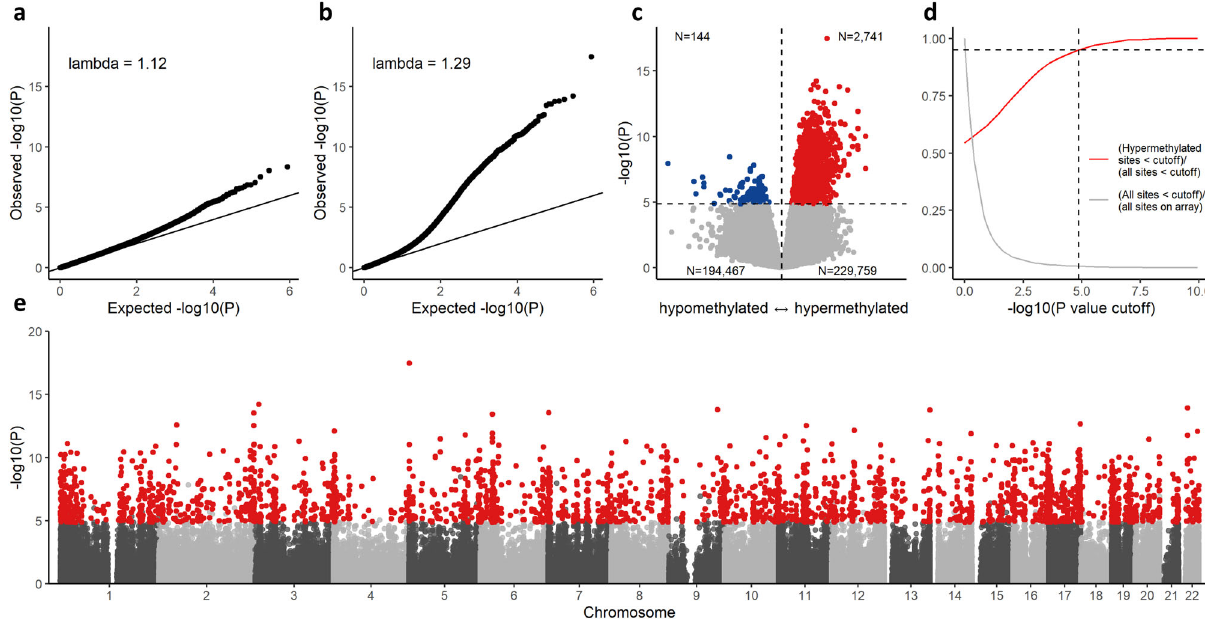
Fig. 1 Epigenome-wide association studies of DNMT3A and TET2 mutations. a QQ plot the P value distribution in differential methylation analyses by DNMT3A mutation status (55 DNMT3A -mutated inviduals compared to 189 individuals without CHIP). b Same as A, but comparing 44 TET2 -mutated individuals to 189 without CHIP. c Volcano plot of results from TET2 -speci fi c analyses. Horizontal dashed line indicates P = 1.4 × 10 − 5 . Numbers in corners indicate the number of CpG sites in each quadrant separated by dashed lines. Red and blue dots represent hyper- and hypomethylated CpG sites, respectively, below the signi fi cance threshold. d Selection of P value cutoff used in C. Red line displays the increasing proportion of hypermethylated sites with decreasing P value cutoff. Horizontal dashed line indicates 95% of sites are hypermethylated. Vertical dashed line indicates selected P cutoff of 1.4 × 10 − 5 . e Manhattan plot with the 2741 CpG sites showing TET2 mutation-associated hypermethylation highlighted in red. P values and effect size estimates in all panels derived using a linear mixed effects regression with twin pair as random intercept. All P values are two-sided and not adjusted for multiple comparisons.